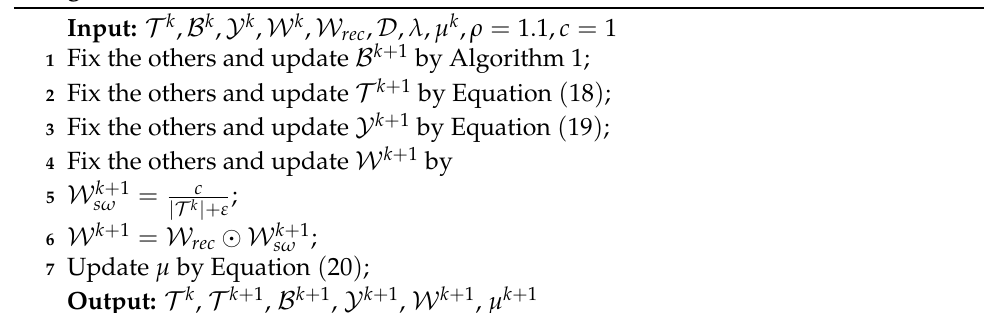
Algorithm 2: The k -th iteration flow of ADMM